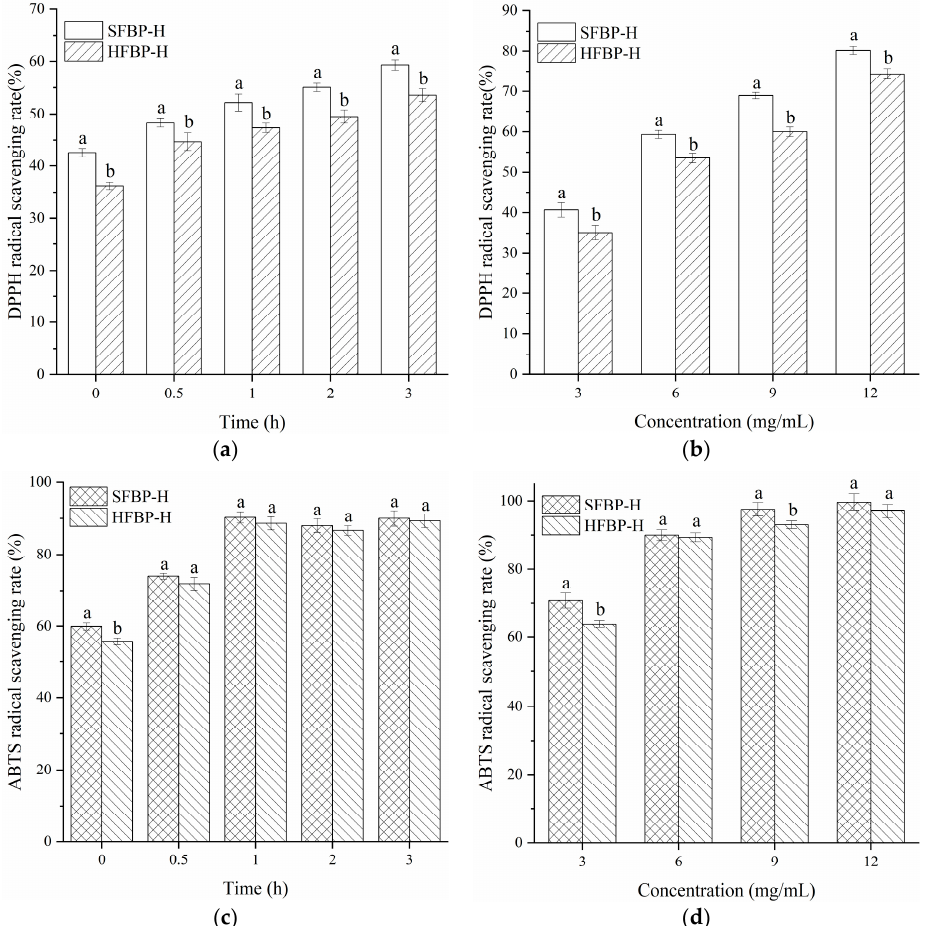
Figure 5. Antioxidant activities of SFBP-H and HFBP-H. DPPH radicals scavenging activity ( a ) and ABTS radicals scav- enging activity ( c ) of SFBP-H and HFBP-H treated with Flavourzyme for various hydrolysis times (0–3 h); the concentra- tion of all hydrolysates used in the experiments was 6 mg/mL. DPPH radicals scavenging activity ( b ) and ABTS radicals scavenging activity ( d ) of SFBP-H and HFBP-H at various concentrations after hydrolysis for 3 h. SFBP: fish bone protein prepared through steam explosion-assisted extraction; HFBP: fish bone protein prepared through hot-pressure extraction; SFBP-H: SFBP hydrolysates; HFBP-H: HFBP hydrolysates. Different letters indicate that the results of SFBP-H and HFBP- H differ significantly ( p <